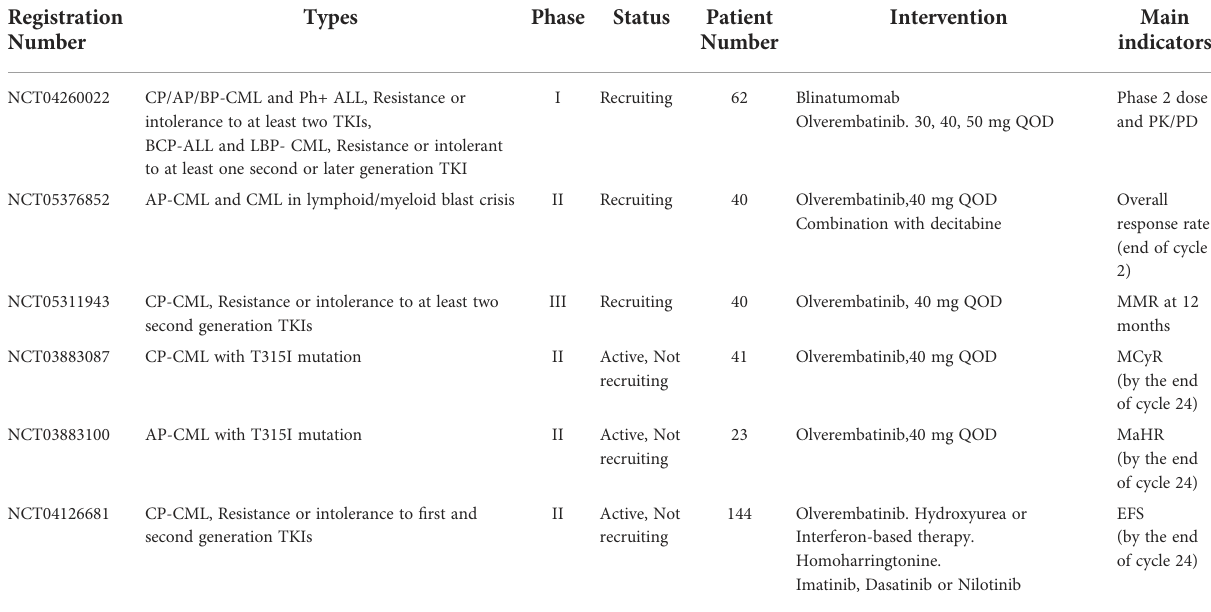
TABLE 3 Clinical studies of